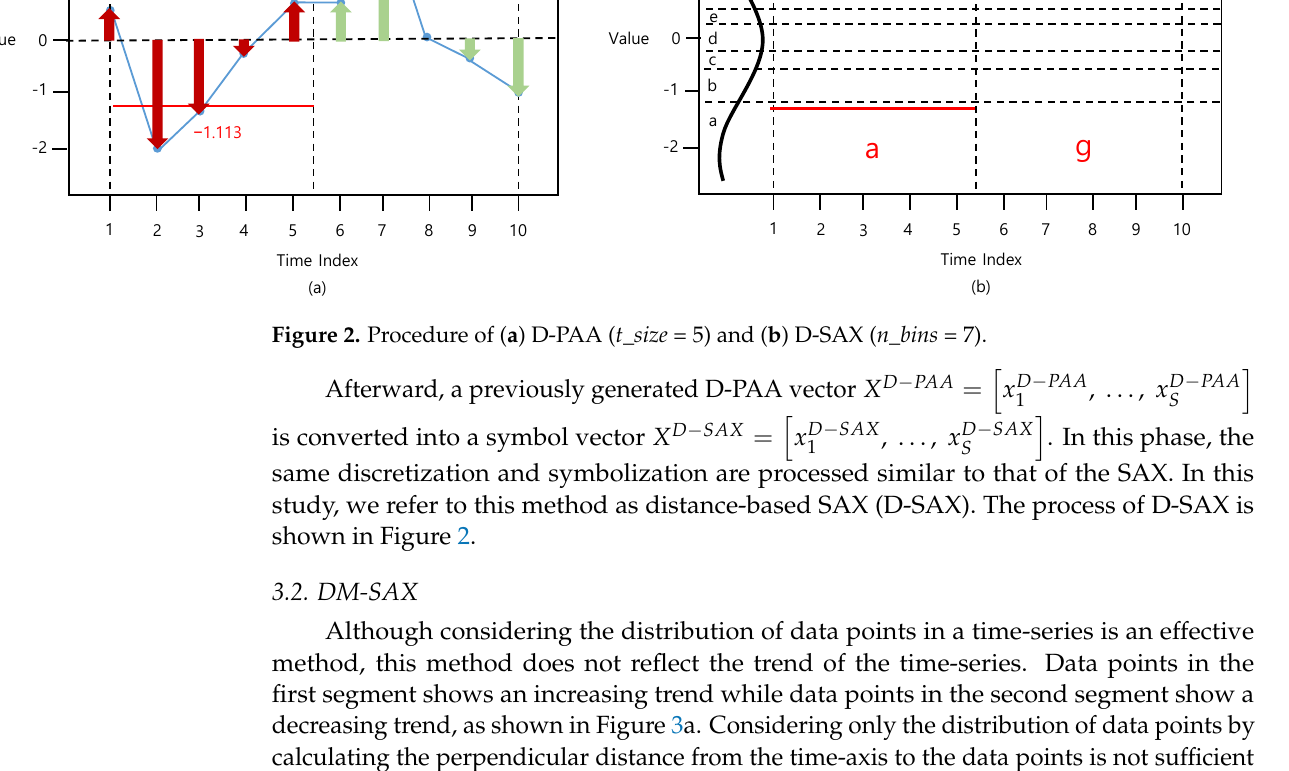
calculating the perpendicular distance from the time-axis to the data points is not sufficient to appropriately represent a given time-series.